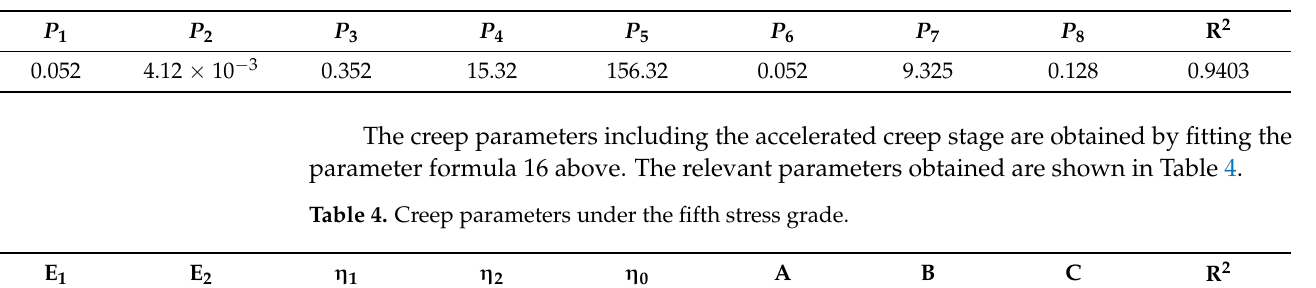
Figure 18. Through the analysis of the fitted curve, the following conclusions can be drawn: (1) According to the observation of the curves, the specimens with porosity interval of 10~15% are nearly identical with the curves of the test data under the three stress loading levels of 2 MPa, 4 MPa, and 6 MPa, indicating that the model can well describe the creep characteristics of coal